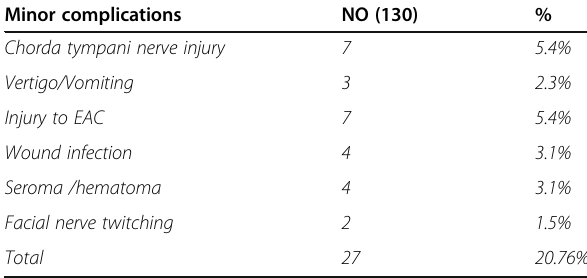
Table 1 Minor complications among studied group